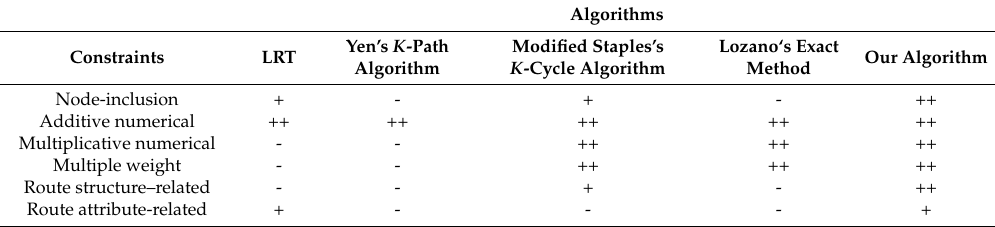
Table 3. Constraints supporting comparison between different algorithms.